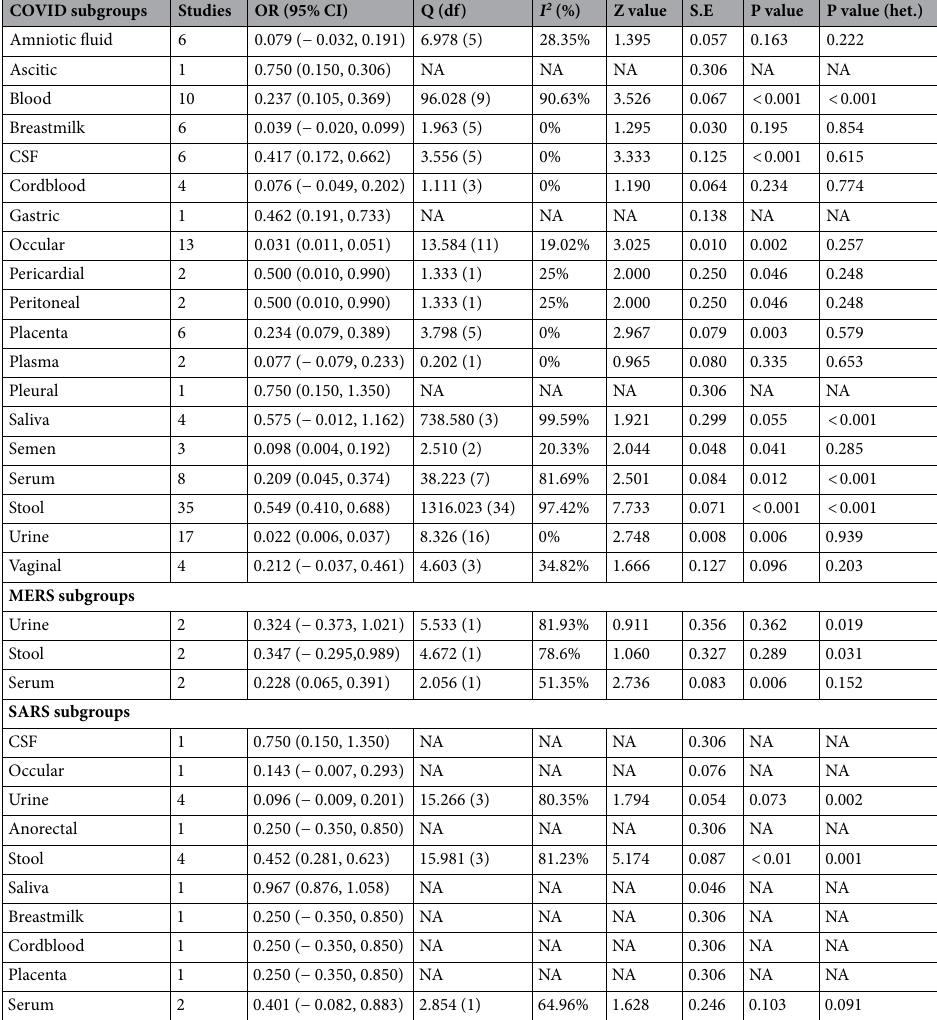
Table 1. Subgroup analysis (Specimen) and meta-regression for heterogeneity using Random-Effects